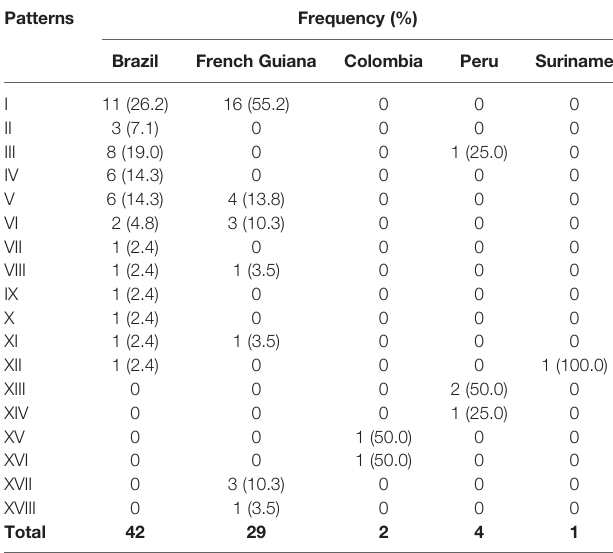
TABLE 5 | Frequencies of PfHRP2 sequence patterns of Plasmodium falciparum isolates from South America.